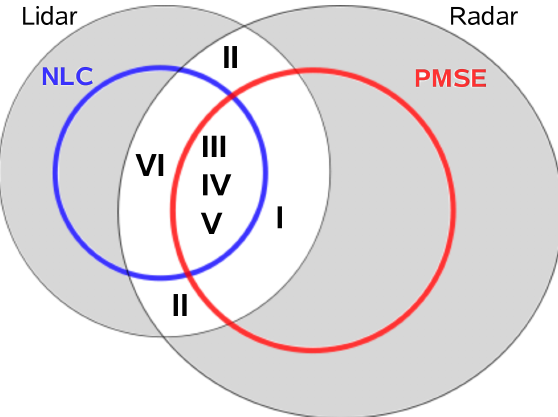
Fig. 4. Schematic drawing of lidar and radar data set (big circles). The colored circles include the measurements where NLC or PMSE were detected. The regions I to VI make up the simultaneous mea- surements according to the PMSE and/or NLC occurrence. The shaded areas are discarded. Areas are not to scale.